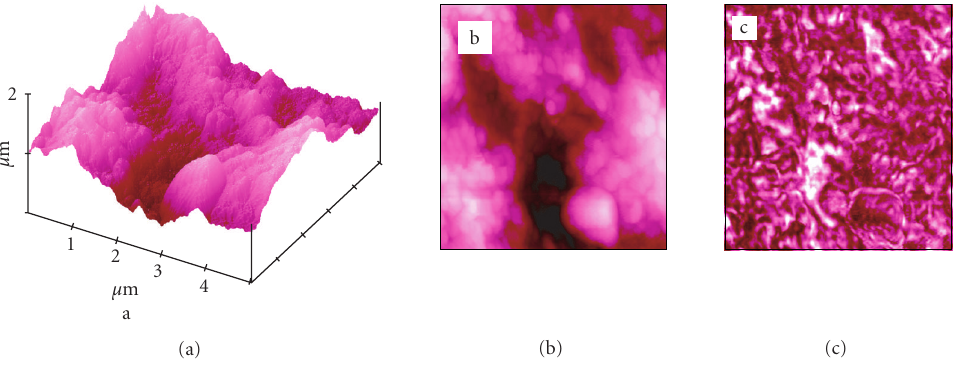
Figure 21: Shear-force AFM (a), (b) and apertureless SNOM (c) of an unstained cryomicrotome cut of a shrimp eye in the peripheral region resolving various organelles by topography and chemical contrast in the optical image.